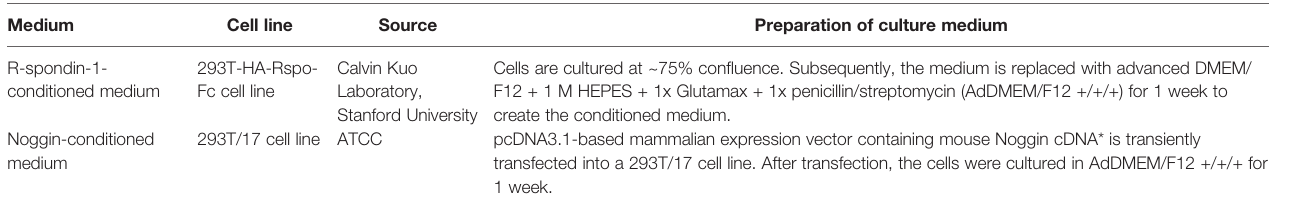
TABLE 3 | Preparation of Noggin-conditioned medium and R-spondin-1-conditioned medium for organoids (27, 35, 36).